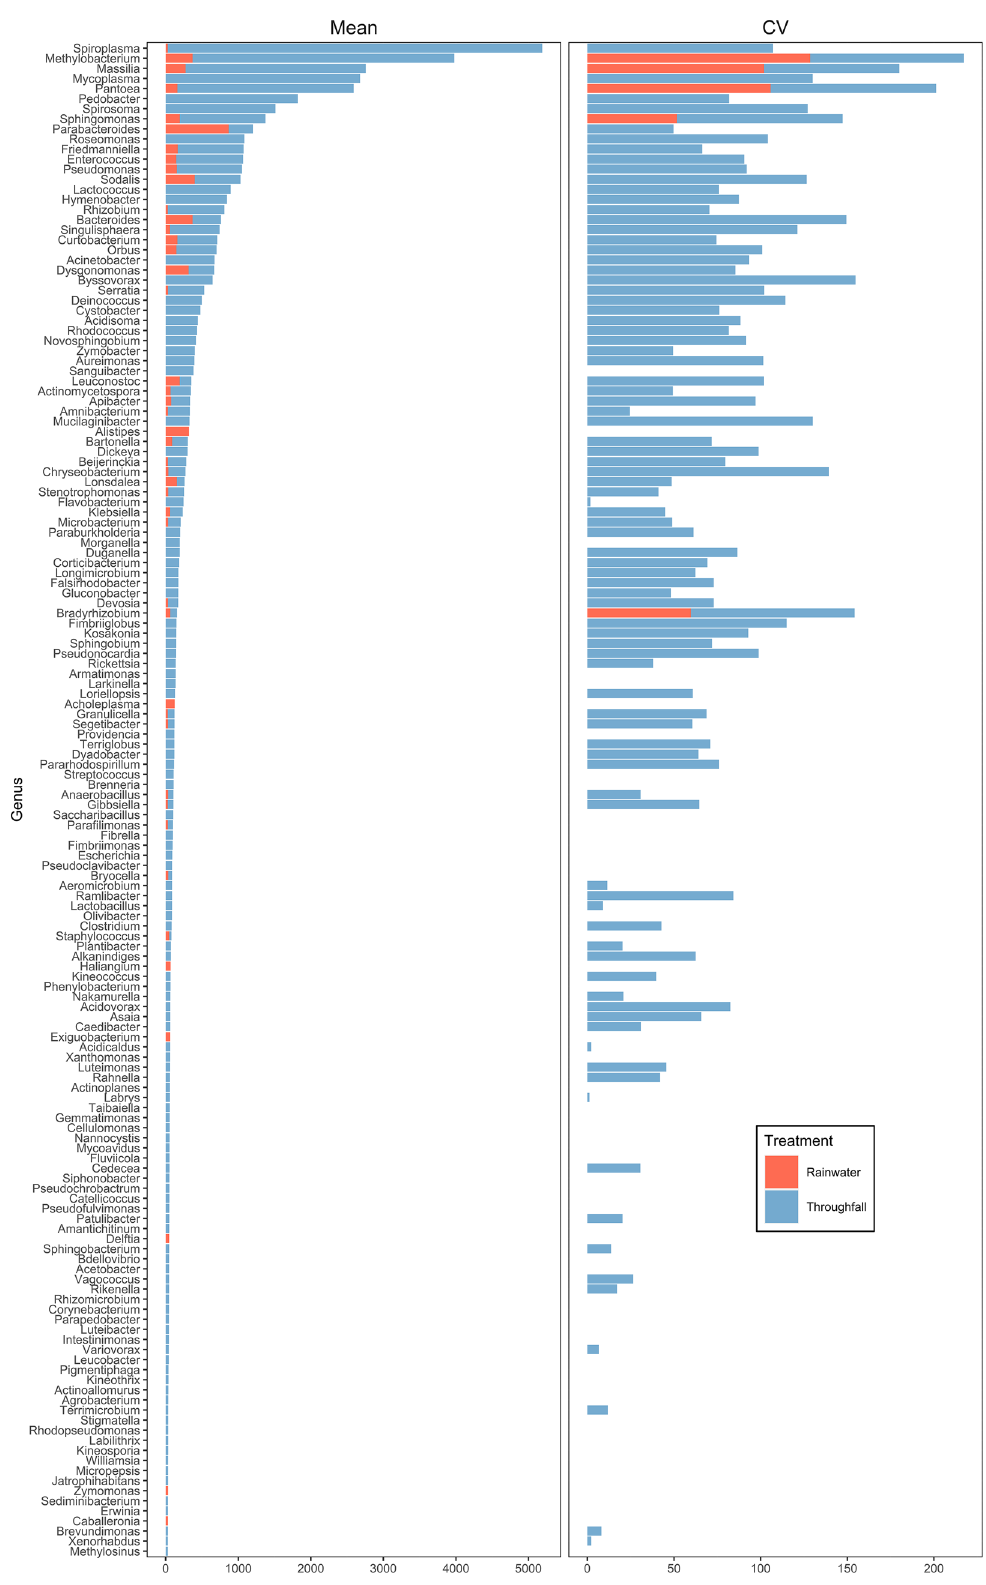
Figure 5. Mean abundance (number of ASV reads) and coefficient of variation (CV) for taxonomically- assigned ASVs for 151 unique bacterial genera detected in rainwater (red) and throughfall (blue)